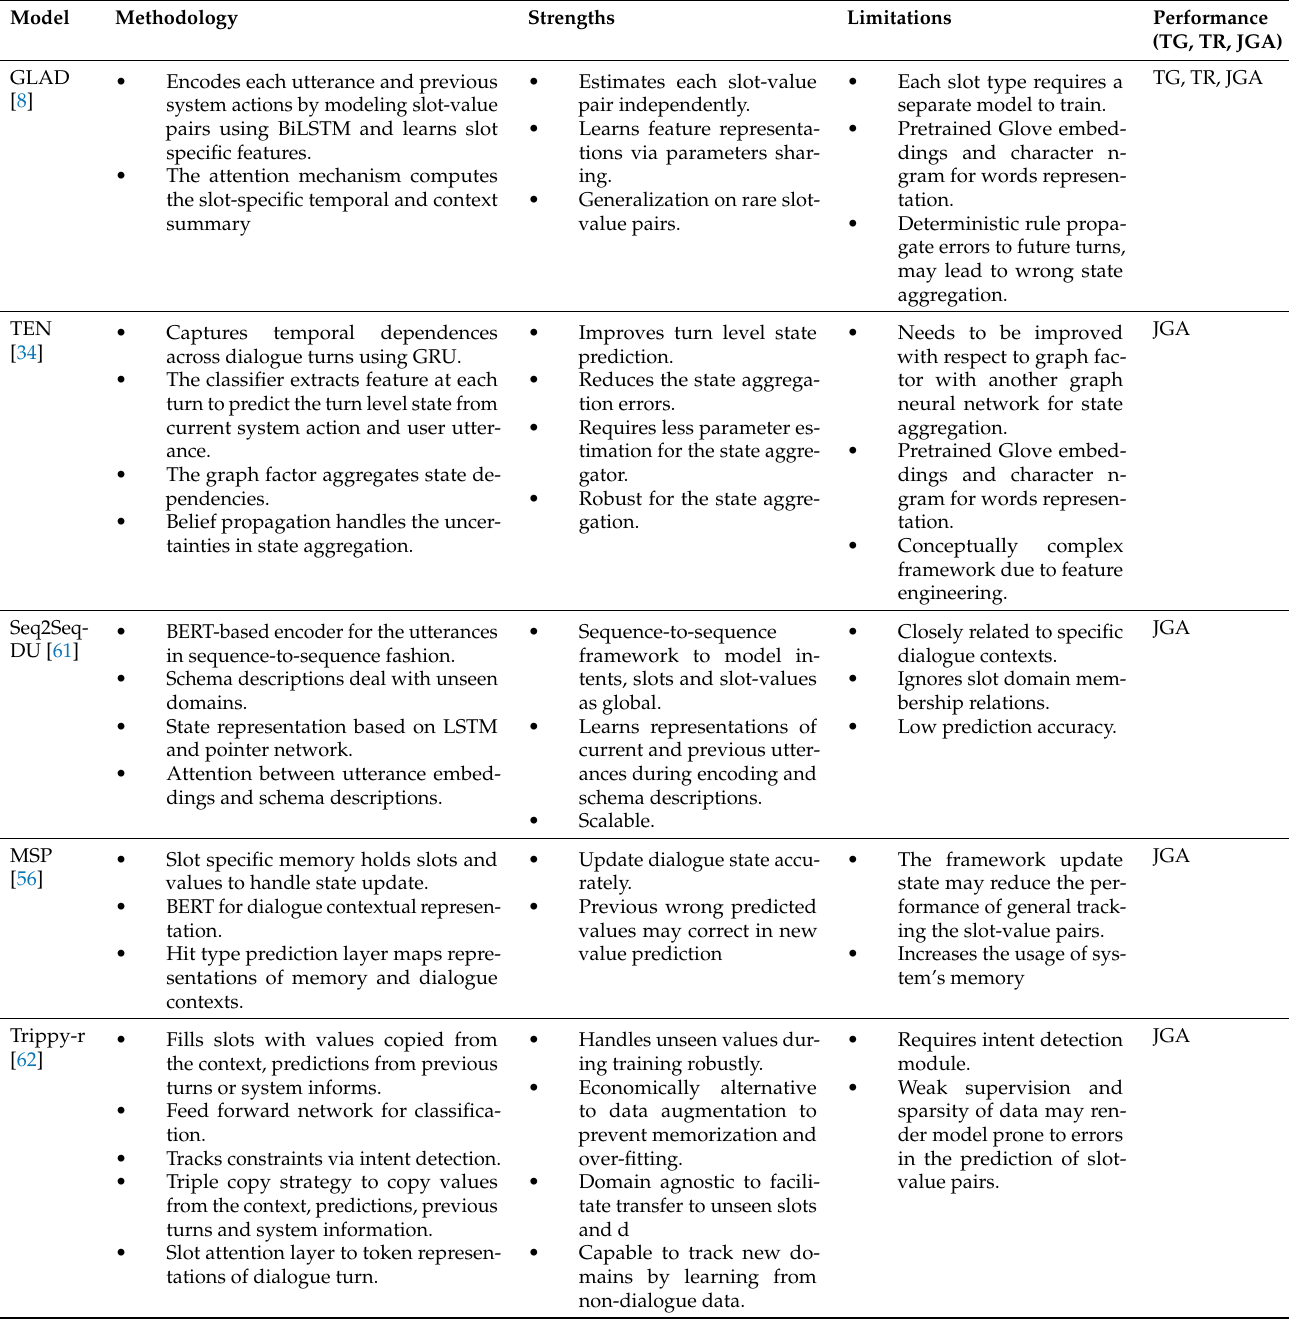
Table 1. Comparison of latest studies exploring the DST problem, where TG, TR, and JGA, denote Turn Goal, Turn Request, and Joint Goal Accuracy,